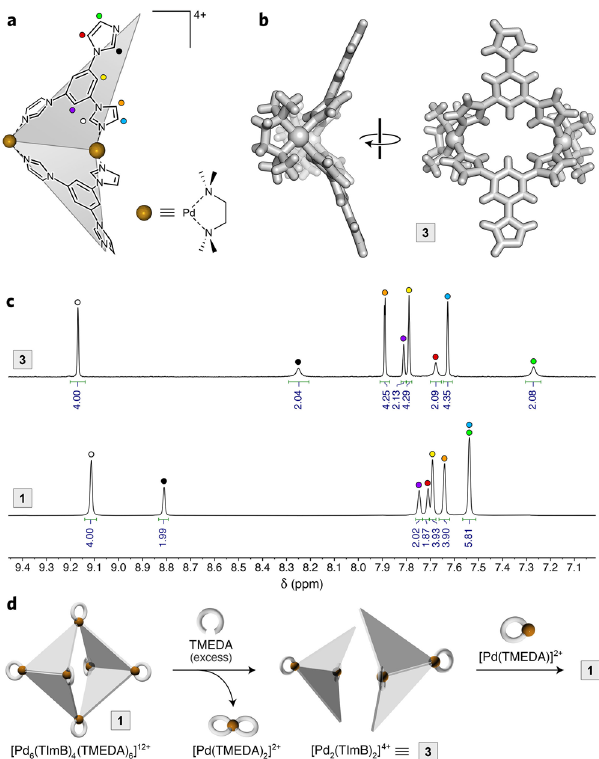
Fig. 4 Characterization of “ half-cage ” 3. a Structural formula of 3 . b Crystal structure of 3 . Nitrate counterions and water molecules were omitted for clarity. c Top: Partial 1 H NMR spectrum of 3 (600 MHz, D 2 O, 300 K) (for full-range 1 H and 13 C spectra, see Supplementary Figs. 20 – 22). Bottom: Partial 1 H NMR spectrum of 1 (600 MHz, D 2 O, 300 K). d Cartoon representation of the extraction of axial Pd 2 + centers from cage 1 using TMEDA, followed by reassembly of cage 1 from 3 using [Pd(TMEDA)] 2 + .